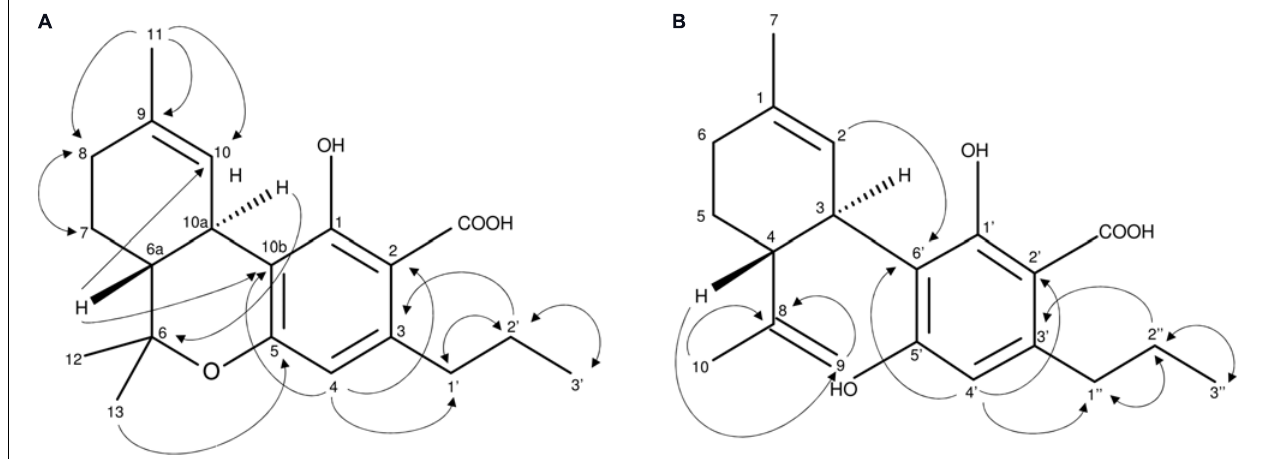
FIGURE 2 | (A,B) Important 1 H- 1 H-COSY and HMBC NMR correlations of compounds 1 (A) and 2 (B) describing the C 3 -alkyl side chain of 1 (A) and 2 (B) as well as the opened pyran ring of 2 .